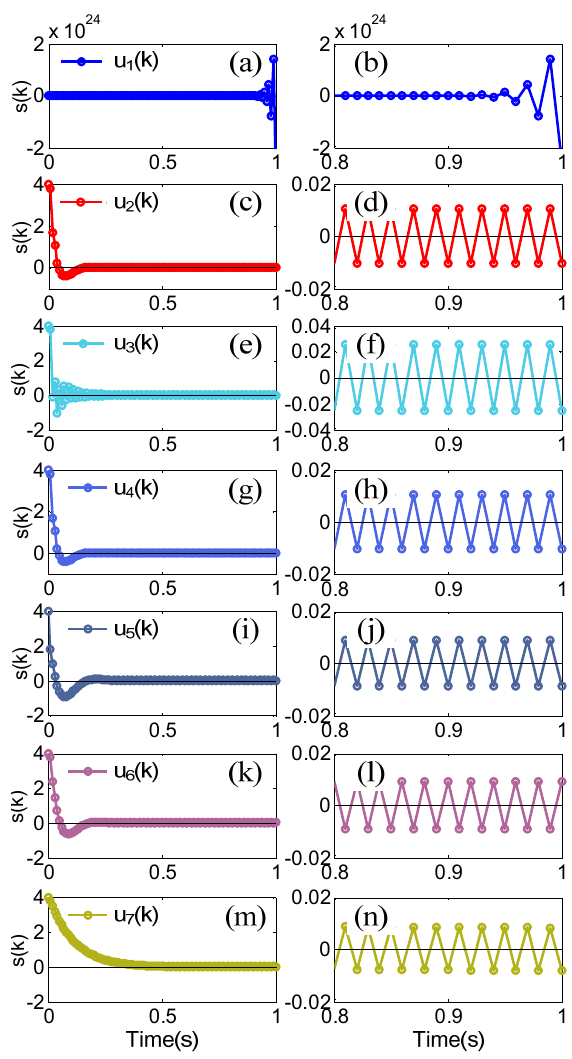
Figure 2. Switching function s ( k ): ( a ) u 1 ( k ); ( b ) Zoom view of Figure 2a; ( c ) u 2 ( k ); ( d ) Zoom view of Figure 2c; ( e ) u 3 ( k ); ( f ) Zoom view of Figure 2e; ( g ) u 4 ( k ); ( h ) Zoom view of Figure 2g; ( i ) u 5 ( k ); ( j ) Zoom